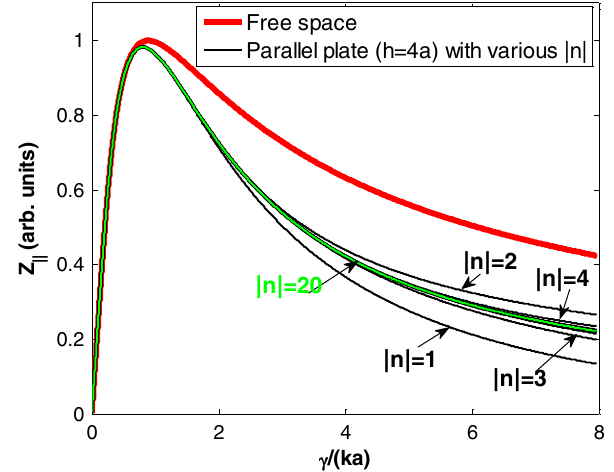
FIG. 4. The effect of image bunches on the on-axis LSC impedance of a round transversely uniform beam centered between a parallel-plate chamber. The bunch has a radius of a ¼ 5 mm. The full height of the parallel plate is h ¼ 4 a ¼ 20 mm. The family of black lines shows the calculated impedances with different maximum index j n j of image beams in Eq. (26) ranging from 1 to 20. The green line in the plot shows the calculated impedance with j n j ¼ 20